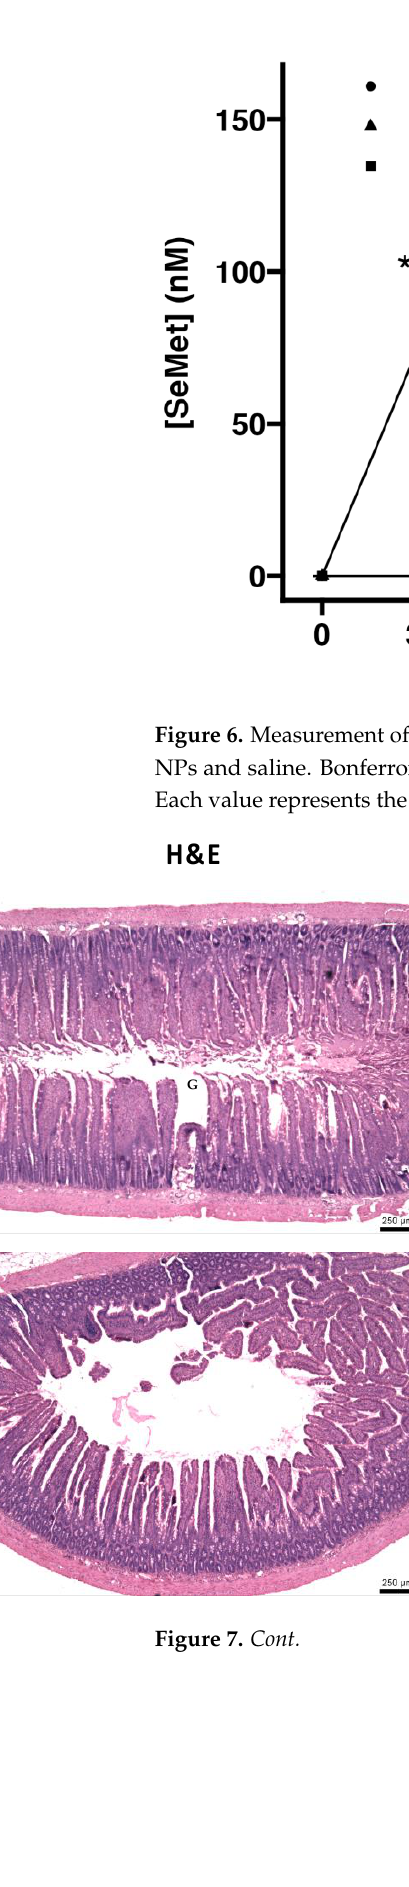
Figure 7. H&E and Alcian Blue and neutral red staining of mucosae 180 min after intra-jejunal in- stillations. Groups: PBS control, free SeMet (20 μg/kg), SeMet NP (20 μg/kg). Images captured using a light microscope. Goblet cells are indicated by ‘G’. Black arrows show epithelial sloughing. Hori- zontal bars on panels = 250 μm. 3. Discussion A better understanding of the potential obstacles and mechanisms of intestinal ab- sorption for oral supplementation of SeMet is required. The focus of this work was the assessment of the cytotoxicity and stability of SeMet, with a specific focus on the uptake of SeMet within the body using in vitro, ex vivo and in vivo models of assessment. The antioxidant potential was first investigated. An inverse relationship between the SeMet concentration and fluorescent intensity was observed in the ROS assay, suggesting a con- centration-dependent reduction in the build-up of peroxides, hydroxides and hydroxyl radicals via scavenging. The antioxidant potential of SeMet has also been demonstrated using other assays, such as 1,1-diphenyl-2-picryl-hydrazyl, cupric-reducing antioxidant capacity and the Folin–Ciocalteu assay [28]. Miranda et al. indicated SeMet treatment as low as 10 nM on isolated epithelial cells can modulate apoptosis and proliferation, inde- pendent of a selenoprotein-mediated reduction of hydrogen peroxide [29]. Zhang et al. also observed that SeMet activates the Nrf2/HO-1 signalling pathway, which increased the expression of downstream antioxidant enzymes and reduced the content of ROS in